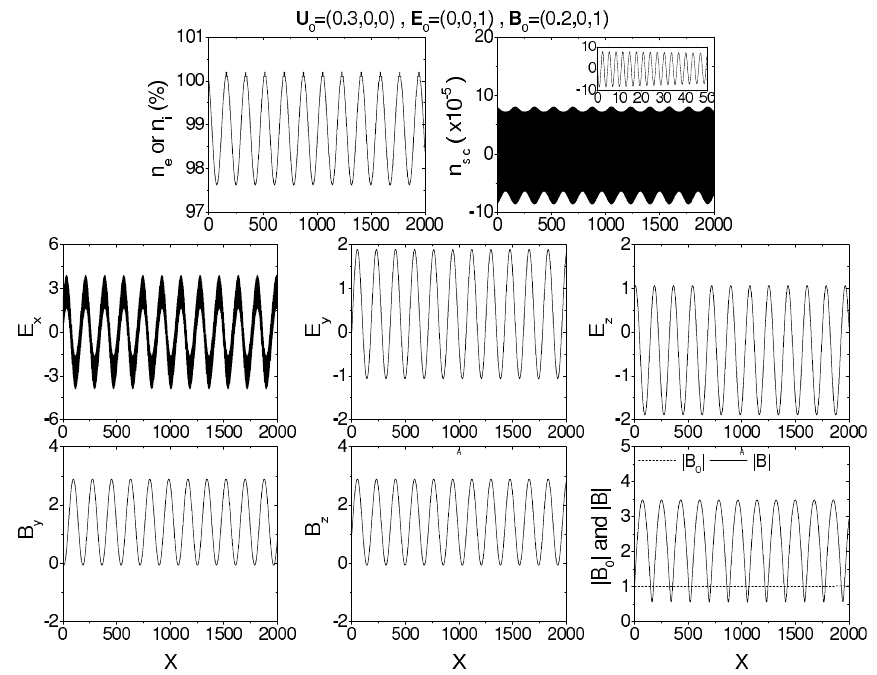
Fig. 4. Sinusoidal IA/IC solitary structures driven in a nonlinear system where all variables depend only on the x -coordinate (a slab model). Shown in panels of the figure are solitons’ density ( n e or n i ; top left), space-charge density inserted by an enlarged curve ( n sc ; top right), electric wave-field components ( E x , E y , E z ; middle row), magnetic wave-field components B y (lower left) and B z (lower middle), and, total magnetic field strengths [initial | B 0 | and soliton | B(X) | ; lower right]. Input parameters are as follows: M =1, m i /m p =16, ξ m =1836.2, ξ T =10, ξ v =0.1.